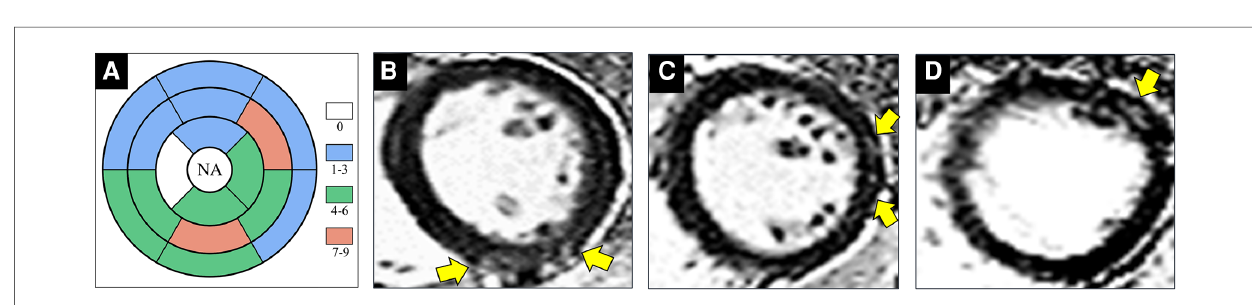
FIGURE 3 Images show representative examples of HIV-1-infected patients with positive late gadolinium enhancement (LGE). (A) Distribution of positive LGE according to segments of myocardium indicates preferable involvement of mid- subepicardial-wall in the inferior segments and superior-lateral segments. (B) 30-year-old male patient underwent cardiac magnetic resonance (CMR) imaging after one year of HIV diagnosis. Phase-sensitive inversion recovery (PSIR) sequences in short-axis view shows focal enhancement (yellow arrow) at mid-inferior segment. (C) A 34-year-old male patient underwent CMR after one year of HIV diagnosis. Sub-epicardium enhancement (yellow arrow) is visible at mid-inferolateral segment in a patchy pattern. (D) A 29-year-old male patient underwent CMR after fi ve years of HIV diagnosis. Short-axis PSIR image reveals sub-epicardial enhancement at mid-anterolateral segment (yellow arrow). NA=not apply. Abbreviations as in Figure 1 .